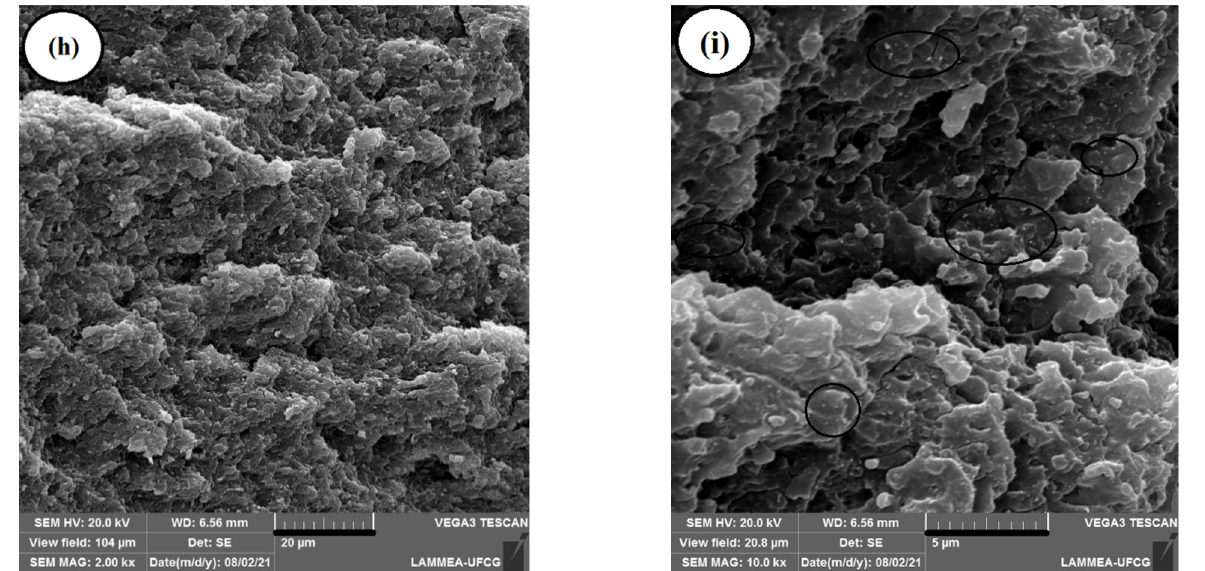
Figure 8. SEM micrographs of the impact test fracture surface: ( a ) Nylon 6 (2000×); ( b ) Nylon 6/ABS (2000×); ( c ) Nylon 6/ABS/ABS-g-MA (2000×); ( d , e ) Nylon 6/ABS/ABS-g-MA/MWCNT (1 phr) (2000× and 10,000×); ( f , g ) Nylon 6/ABS/ABS-g-MA/MWCNT (3 phr) (2000× and 10,000×); ( h , i ) Nylon 6/ABS/ABS-g-MA/MWCNT (5 phr) (2000× and 10,000×).